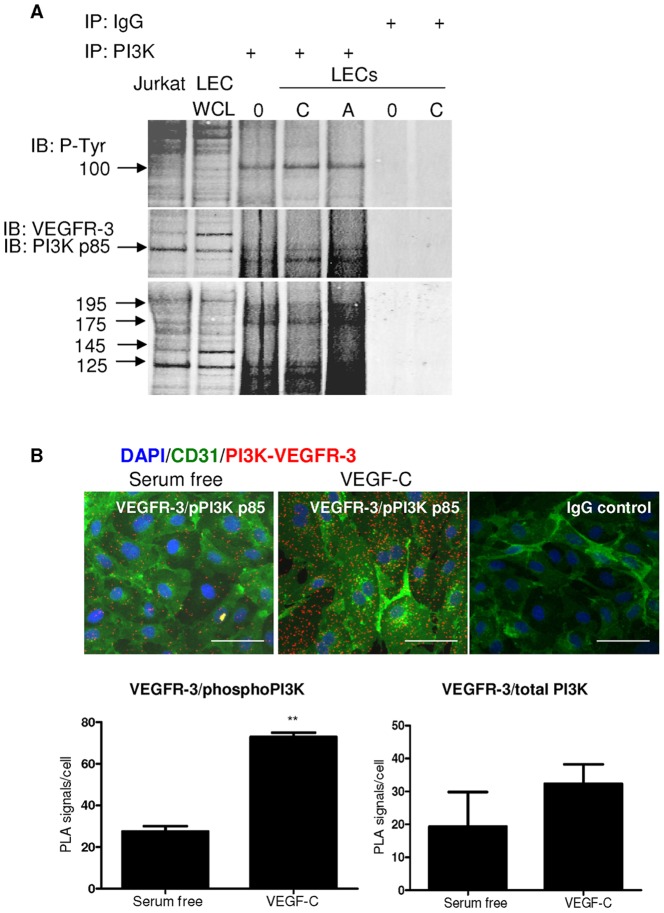
Direct interaction between PI3K p85 and VEGFR-3.
A, LEC whole cell lysate was immunoprecipitated with anti-PI3K or isotype control IgG followed by Western blotting of phospho-tyrosine (p-Tyr), VEGFR-3 or PI3K. LECs were treated with vehicle control (serum-free media ‘0′), IgG control, VEGF-C (100 ng/ml, C) or VEGF-A (100 ng/ml, A) ligand for 15 minutes. Control untreated LEC whole cell lysate is indicate by ‘WCL’ and Jurkat cell lysate served as a positive control (Jurkat). B, Detection of VEGFR-3/phospho-PI3K complexes (red spots) in vitro in LECs grown in absence (B, upper left panel) or presence (B, upper middle panel) of VEGF-C (100 ng/ml) for 15 minutes; CD31 staining (green); DAPI (blue); isotype IgG control in PLA (B, upper right panel); quantification of VEGFR-3/phospho-PI3K and VEGFR-3/total-PI3K PLA signals using Olink Imaging Software (B, lower panel). Data shown as mean±s.e.m. **P<0.01 using t-test analysis. n = 3. Bar = 50 µm.